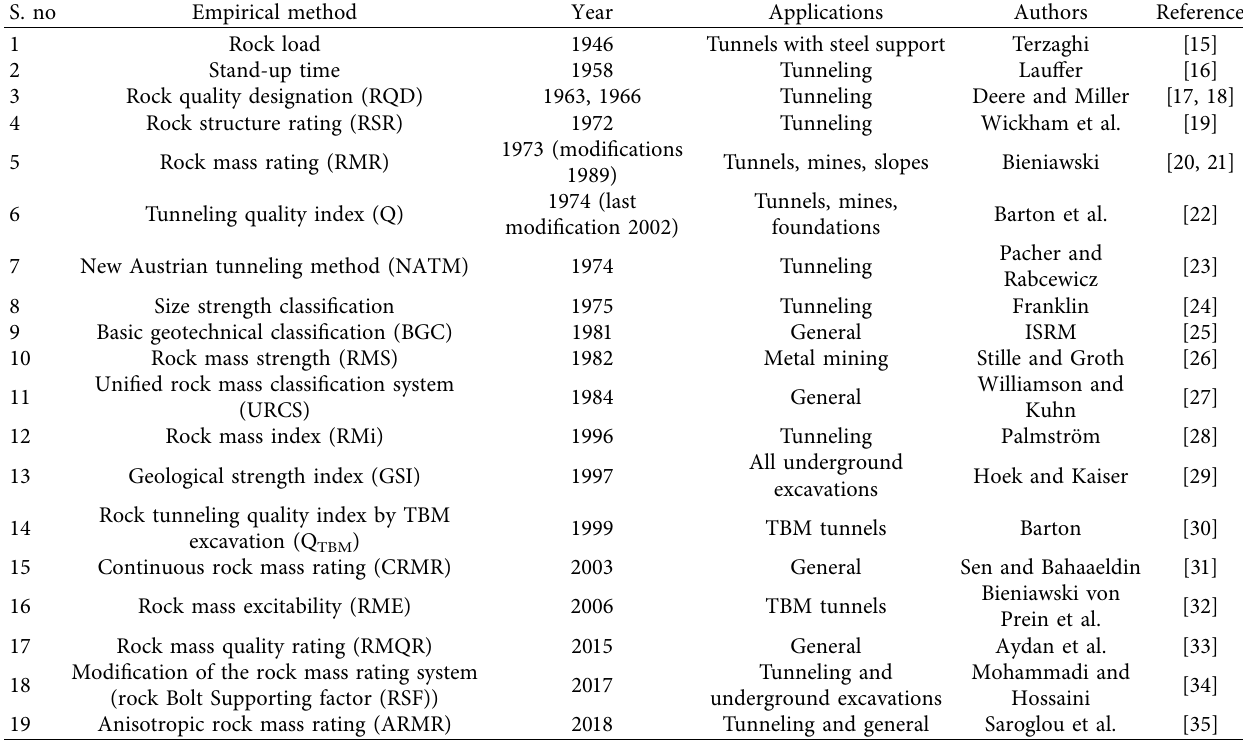
Table 1: Empirical methods for rock mass classification and design of engineering structures in rock